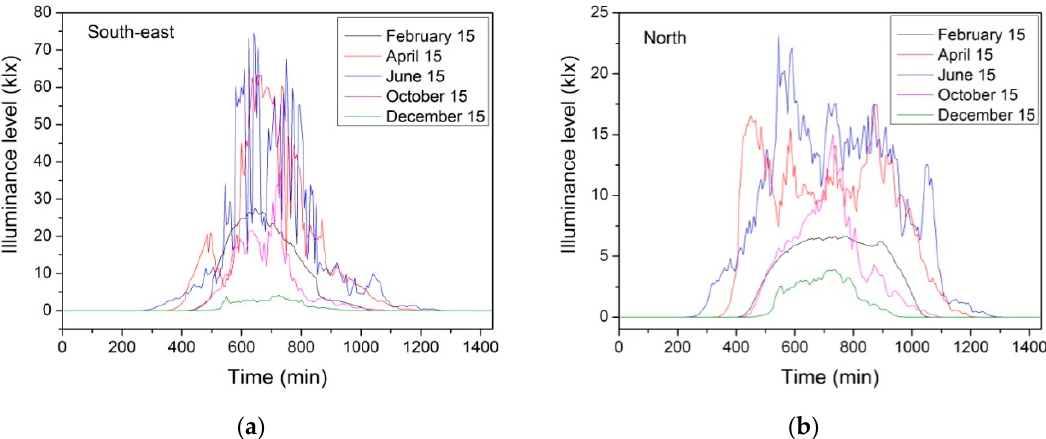
Figure 7. Illuminance levels of daylight measured by sensors located on the south-east ( a ) and north ( b ) side of the building, recorded every two months.